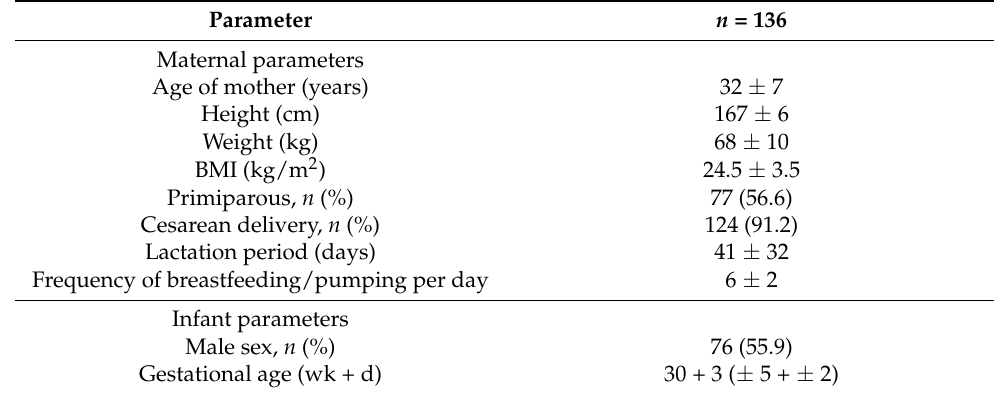
Table 1. Demographic characteristics of mothers and